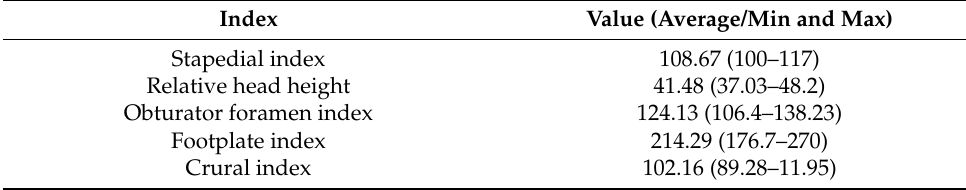
Table 10. Variance indices for the stapes [5].